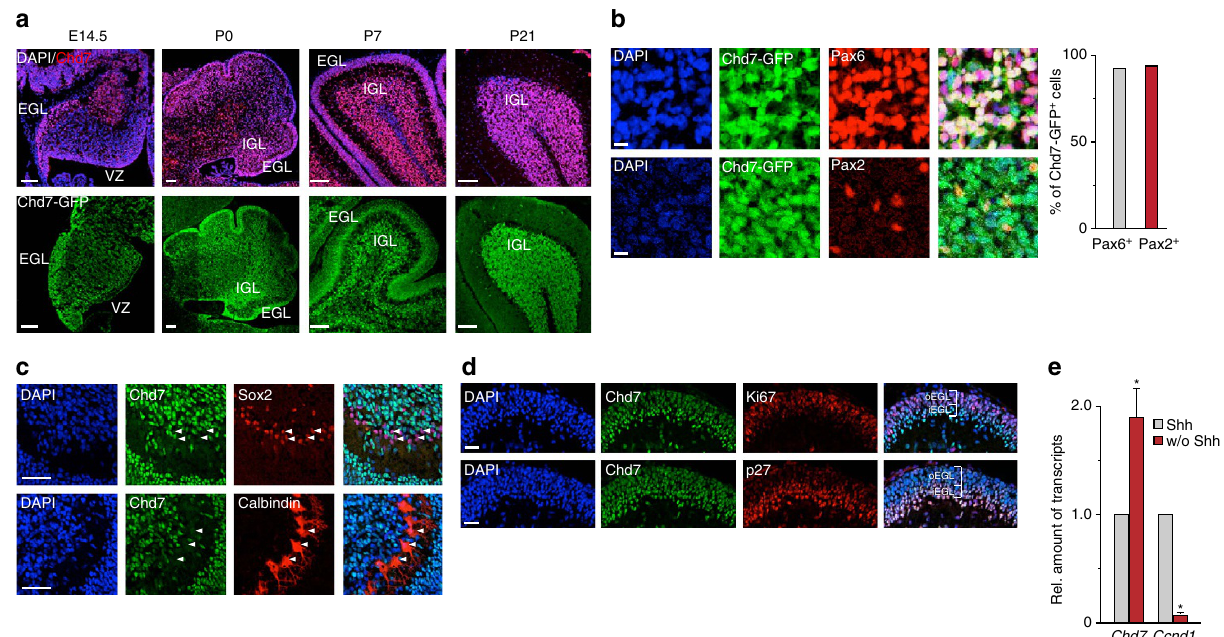
Figure 1 | Chd7 is highly expressed in cerebellar granule cells. ( a ) Immunostaining of Chd7 (red, upper panels) and Chd7-GFP (green, lower panels) in a time series of mouse cerebellum during development. Cellular nuclei were counterstained with DAPI (blue). Scale bars, 100 m m. EGL, external granule layer; IGL, internal granule layer. ( b ) Co-immunostaining of GFP (green) with Pax6 (red, upper panels) and Pax2 (red, lower panels) in the IGL of cerebella of P7 Chd7-GFP reporter mice. Scale bars, 10 m m. The bar graph shows the quantification of percentages of Chd7-GFP þ cells either in Pax6 þ or Pax2 þ cells. ( c ) Co-immunostaining of Chd7 with Sox2 (red, upper panels) and Calbindin (red, lower panels) in cerebella of P7 wild-type C57BL/6J mouse. Arrowheads show very weak staining of Chd7 in Sox2 þ or Calbindin þ cells. Scale bars, 50 m m. ( d ) Co-immunostaining of Chd7 (green) with Ki67 (red, upper panels) and p27 (red, lower panels) in EGL of P7 cerebellum. Scale bars, 25 m m. oEGL: outer EGL. iEGL: inner EGL. ( e ) Quantitative